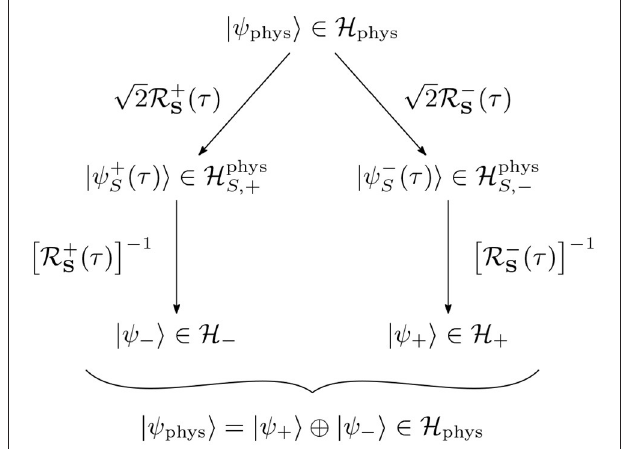
FIGURE 2 | A summary of the Page-Wootters reduction maps and their inverses. The analogous state of affairs holds for the quantum symmetry reduction maps and their